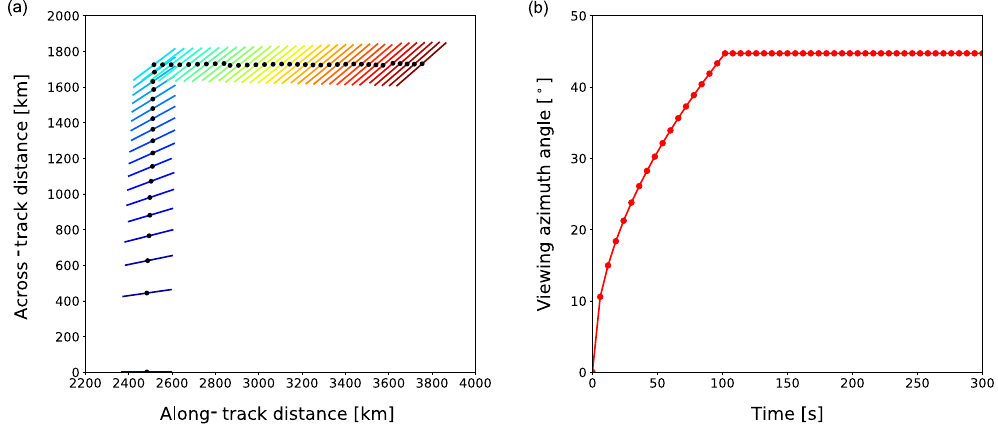
Figure 5. Illustration of the sweep-mode central measurement track (a) and viewing angle variations (b) . Flight direction is to the right, 0 ◦ viewing direction is to the right as well. For a single measurement, the LOS that targets at 70km tangent altitude is traced. In (a) , the solid lines indicate the segments of propagation paths between 70 and 71km in the atmosphere. The locations of corresponding tangent points are represented by black